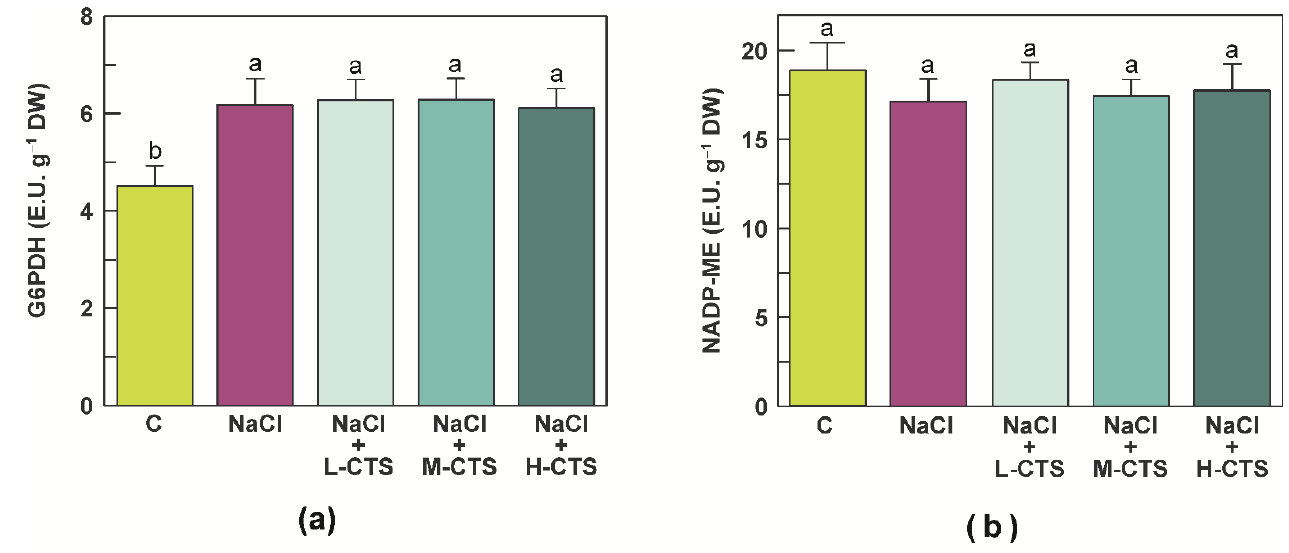
Figure 3. ( a ) Glucose-6-phosphate dehydrogenase (G6PDH) and ( b ) NADP-dependent malic enzyme (NADP-ME) activities in the shoot of durum wheat seedlings grown under control, NaCl stress and NaCl stress + CTS treatment. Vertical bars represent S.D. (n = 3). Different letters indicate significant differences according to the Tukey’s test ( p ≤ 0.05).